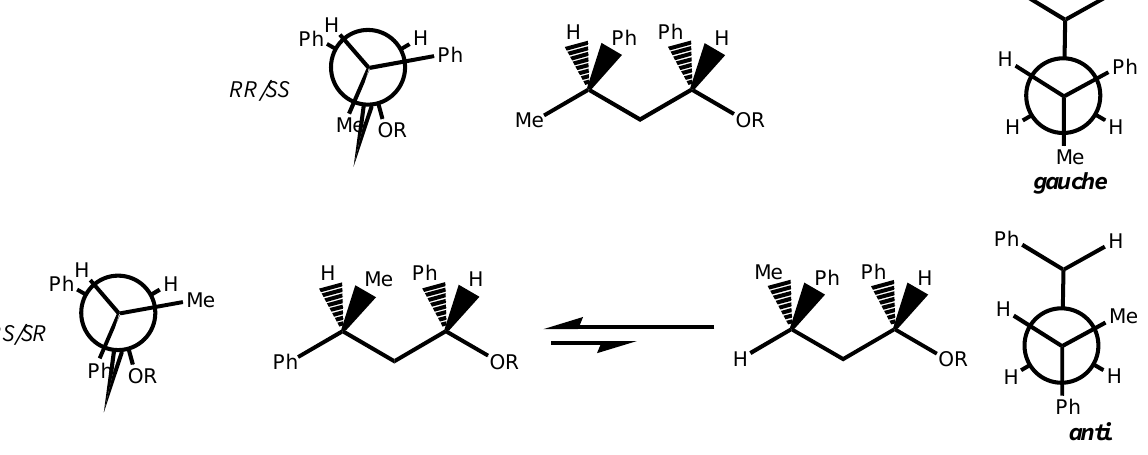
Figure 5. Conformations for the alkyl fragment